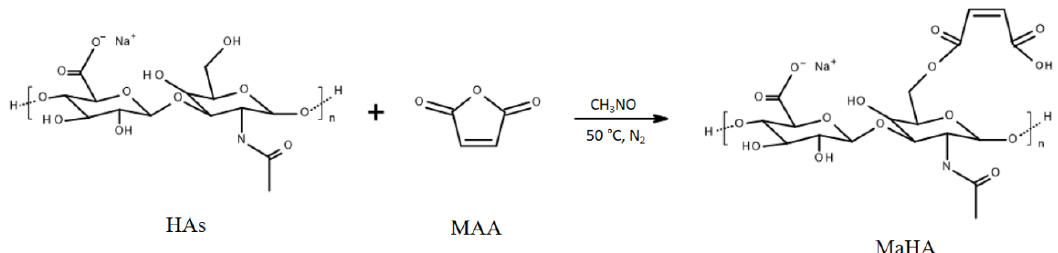
Table 1. Reaction parameters and degree of substitution (DS) for maleated hyaluronic acid (MaHA). Polymers